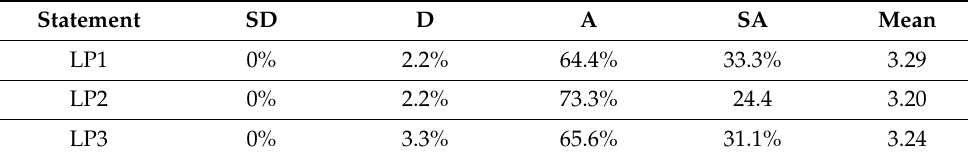
Table 7. Effect of the COVID-19 epidemic on learners’